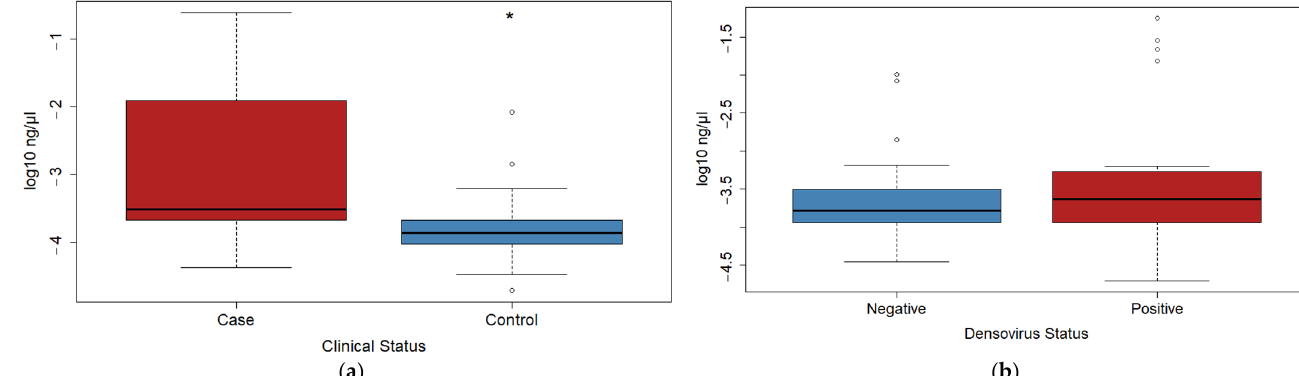
Figure 2. Boxplots of log 10 transformed bacterial loads (ng/µL of hemolymph), as measured by qPCR with the Zymo Femto Bacterial DNA Quantification Kit. Three high outliers were excluded from cases in this figure and corresponding statistical test. ( a ) Bacterial loads were significantly higher in cases than in controls (Wilcoxon rank sum exact test, p < 0.001). Asterisk indicates statistically significant difference; ( b ) bacterial loads were not significantly different between the densovirus- negative and densovirus-positive groups (Wilcoxon rank sum exact test, p = 0.434).